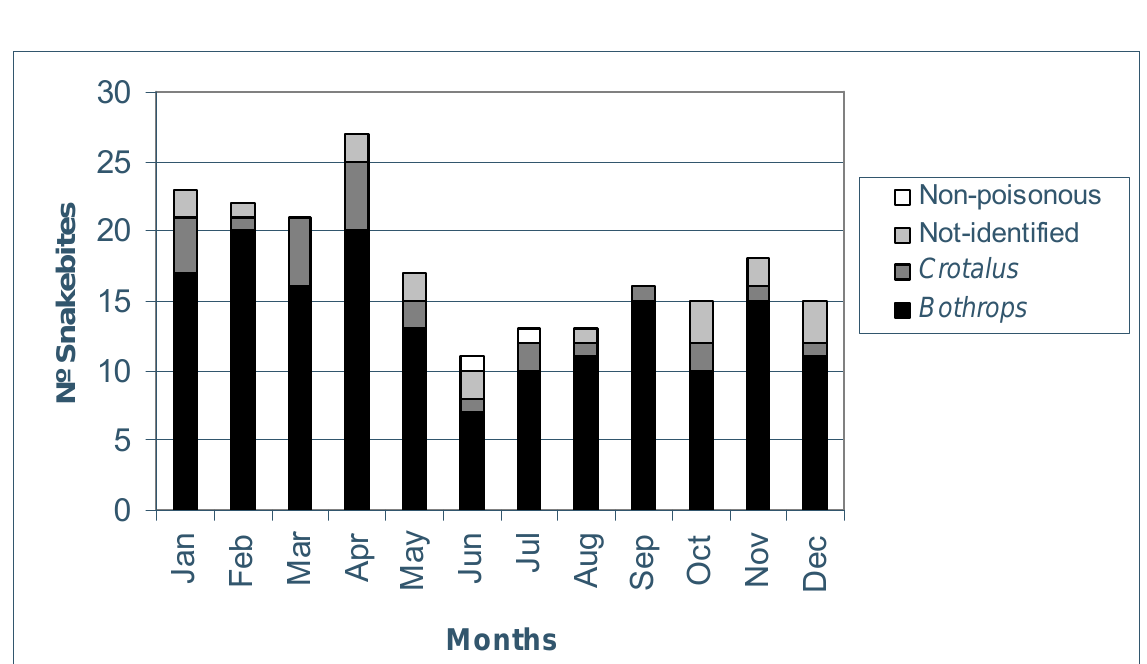
Figure 1. Monthly distribution of snakebites in the Southwest II Regional Health Bureau, Goiás State, Brazil, between January 2002 and December